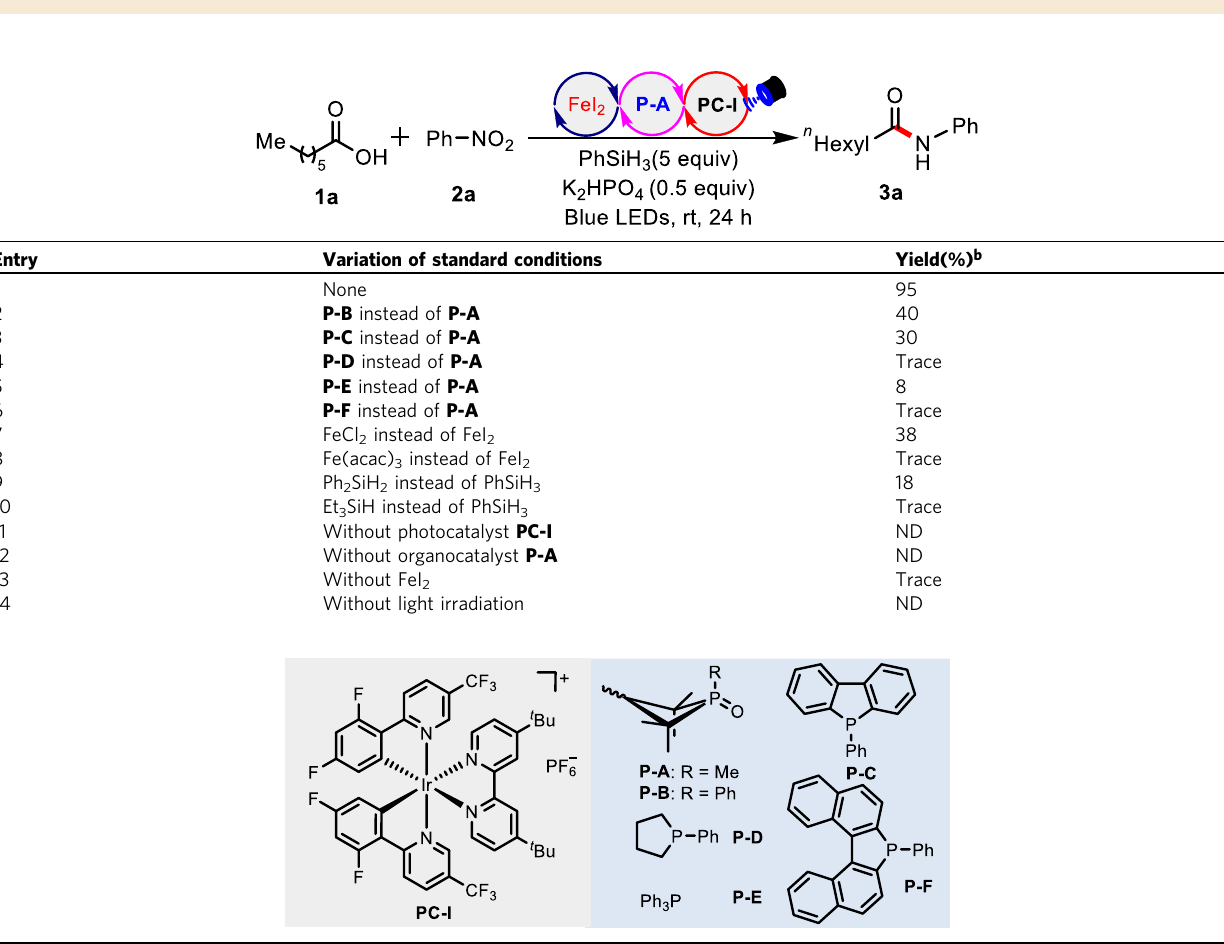
Table 1 Optimization of catalytic Umpolung amidation conditions a